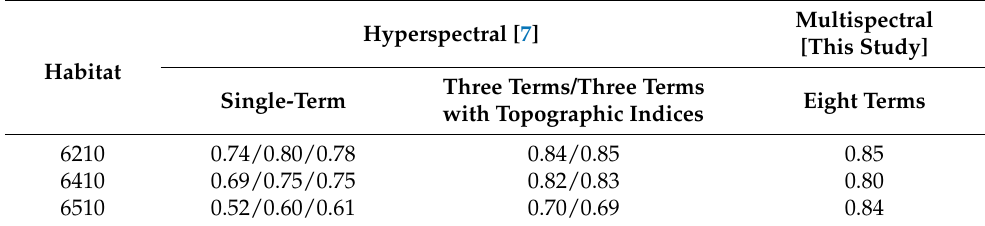
Multispectral [This Study] Eight Terms